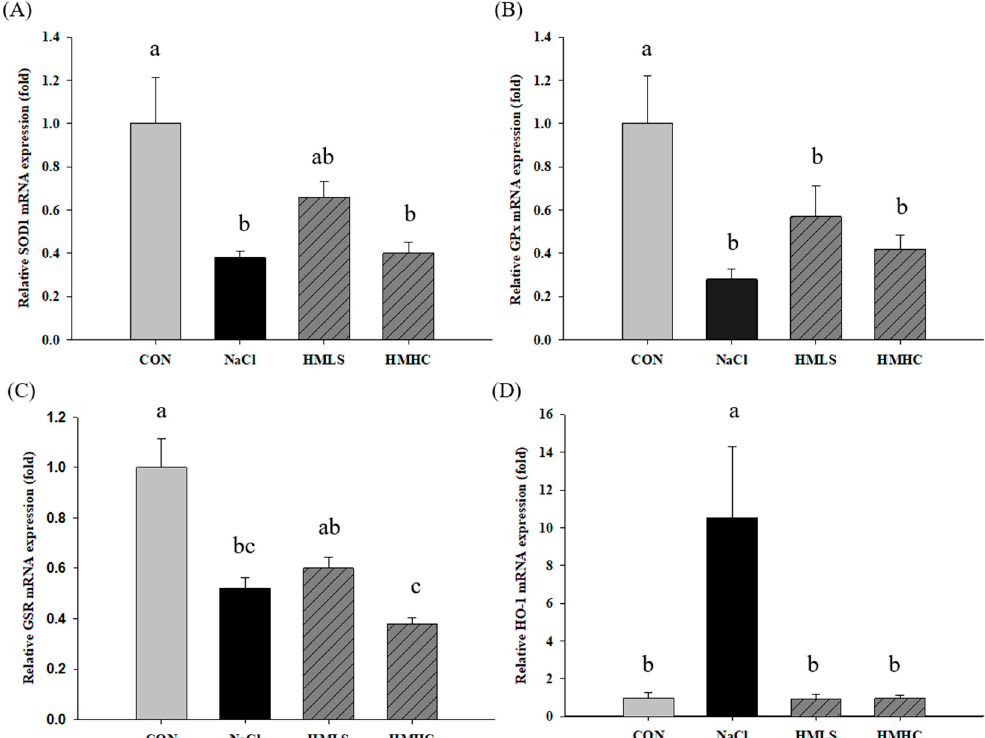
Figure 5. Effects of mineral-balanced DSW on antioxidant related mRNA expression levels of ( A ) superoxide dismutase 1 (SOD1), ( B ) glutathione peroxidase (GPx), ( C ) glutathione disulfide reductase (GSR), and ( D ) heme oxygenase-1 (HO-1). CON, normal diet + distilled water; NaCl, 8% NaCl diet + distilled water; HMLS, 8% NaCl diet + high magnesium low sodium water; HMHC, 8% NaCl diet + high magnesium high calcium water. Different letters above the bars indicate significant differences (Duncan’s multiple range test; p < 0.05).